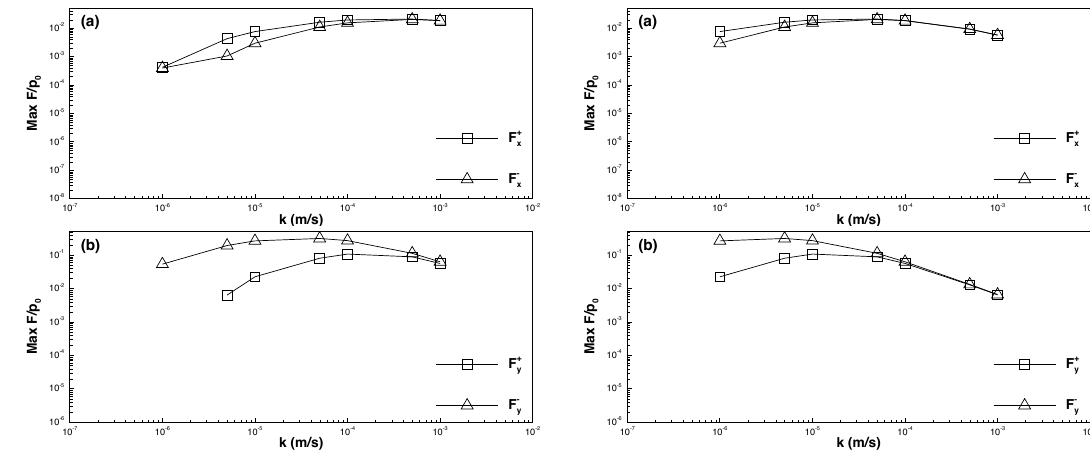
Figure 19. Maximum force on the pipeline in relation to soil permeability; left : E = 1.0 × 10 5 kPa; right : E = 1.0 × 10 6 kPa. ( a ) Horizontal component; ( b ) vertical